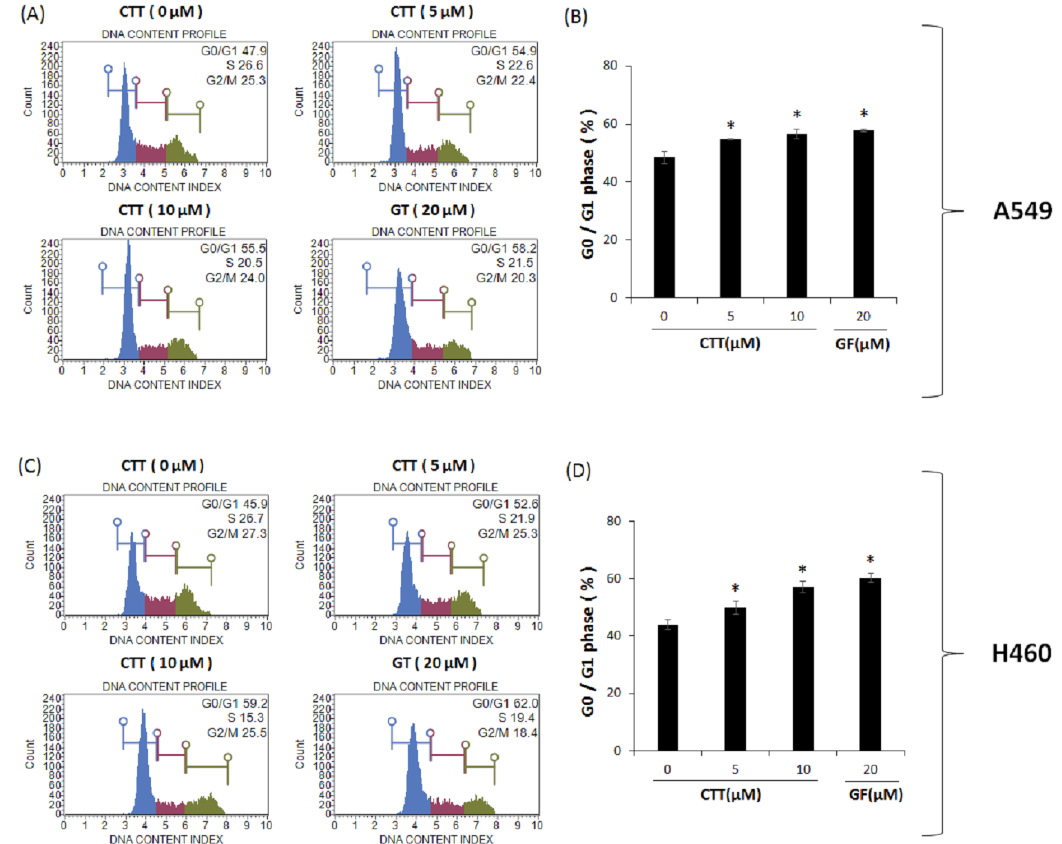
Figure 4. Effects of CTT treatment on G0/G1 phase arrest in A549 and H460 cells. ( A , C ) The cell cycle distribution after 16h treatment with 0, 5, or 10 µ M of CTT or 20 µ M GF (clinical anticancer drug) was measured using flow cytometry. ( B , D ) The histogram of the rate of G0/G1 phase cell was analyzed with a MUSE™ cell analyzer. * p < 0.05 compared to the 0 µ M of CTT group. The data represent each of the three independent experiments. Significant differences for the treated groups were determined by Duncan’s test for multiple comparisons. Values are represented as the mean ± SD from each experiment.